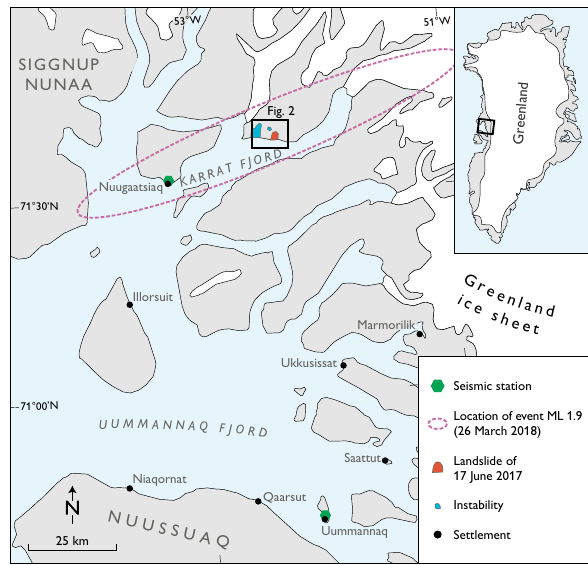
Fig. 1 Overview map of the Uummannaq Fjord area showing the location of the 26 March 2018 1.9 ML seismic event (ellipse) along with the posi- tion of the 17 June 2017 landslide at Karrat and the nearby instabilities. The size of the landslide and nearby instabilities are slightly exaggerated for clarity on the small map scale. Seismic stations in Uummannaq and Nuugaatsiaq are shown along with settlements in the